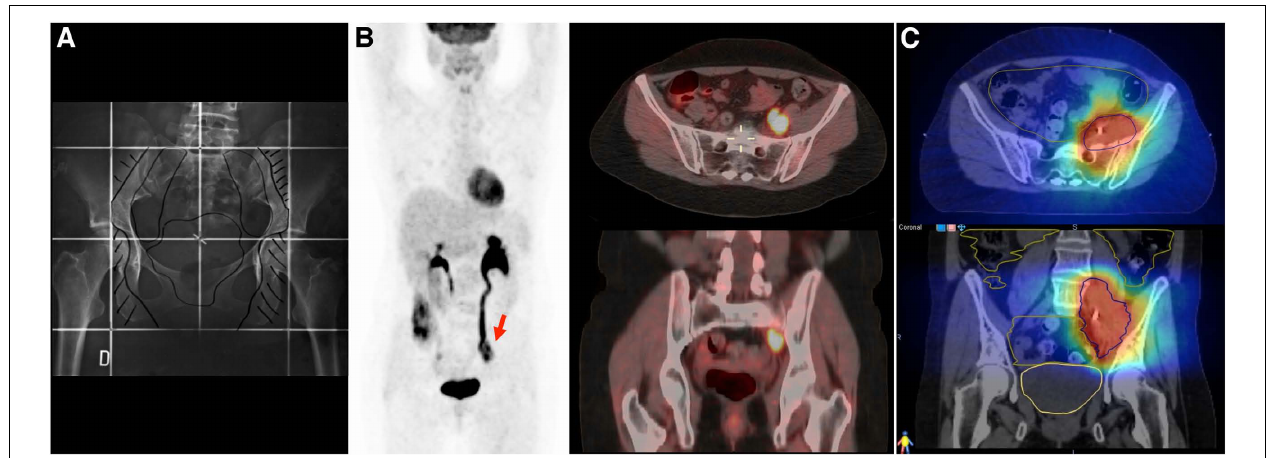
FIGURE 3 |A 43 year-old women with cervical cancer, FIGO IIB, without Kindly specify the same. evidence of macroscopic positive nodes at diagnosis. She was treated with chemotherapy and 3D conformal radiotherapy (45 Gy/1.8 Gy/fraction) followed by brachytherapy. (A) The initial radiotherapy field does not include the irradiation of common iliac nodes. (B) An FDG-PET/CT performed 2 years after primary treatment shows an isolated left iliac recurrence (arrow).This recurrence is observed near the border of the radiation field, which in the context of centrally controlled cervical cancer makes us suspect a component of marginal recurrence that typically arise